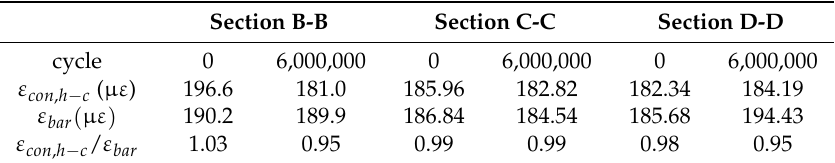
Figure 17. The relationship between the reinforcement strain and applied load. Table 7. Relationship between reinforcement strain and concrete strain.